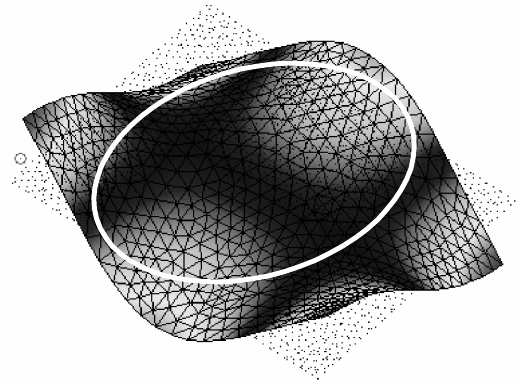
Fig. 7. Amplitude of plate vibrating at f = 1116 Hz.